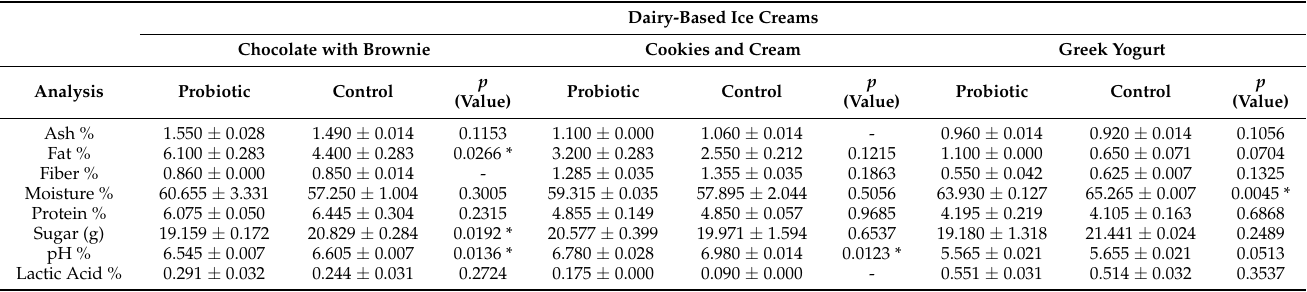
Table 4. Chemical compositions in the control and probiotic ice cream L. fermentum UCO-979C, of dairy-based ice